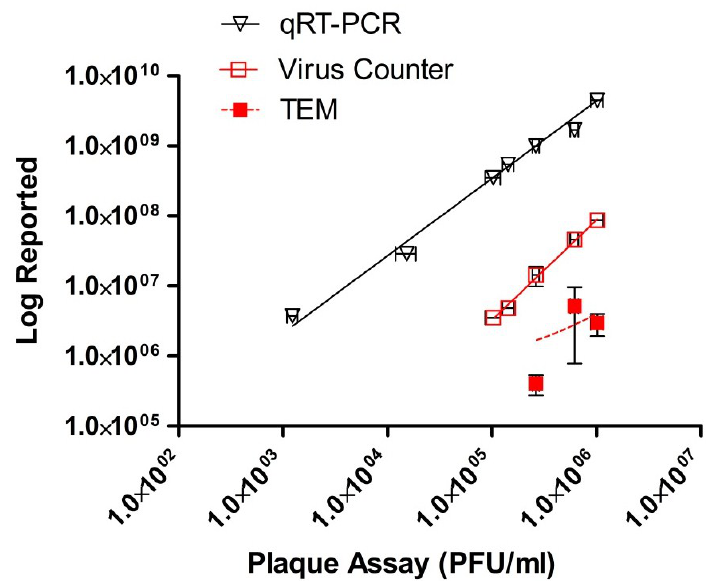
Figure 2. Log-log plot of dilution versus reported concentration for a series of Ebola virus (EBOV), Kikwit variant, samples produced by diluting the stock virus. Infectious virus was quantified for each sample using six well plates of confluent Vero E-6 cells and an agarose-based plaque assay (PFU/mL). All samples were tested in six replicates; bars represent standard deviation. Genomic equivalents were quantified for each sample using an EBOV-specific qRT-PCR (GE/mL). All samples were tested in triplicate; bars represent standard deviation. Virus particles concentration (VP/mL) was quantified from each sample using transmission electron microscopy (TEM). All samples were tested in triplicate. Bars represent standard deviation. Virus particle concentration was also quantified for each sample using the ViroCyt ® Virus Counter 2100 instrument. All samples were tested in triplicate; bars represent standard